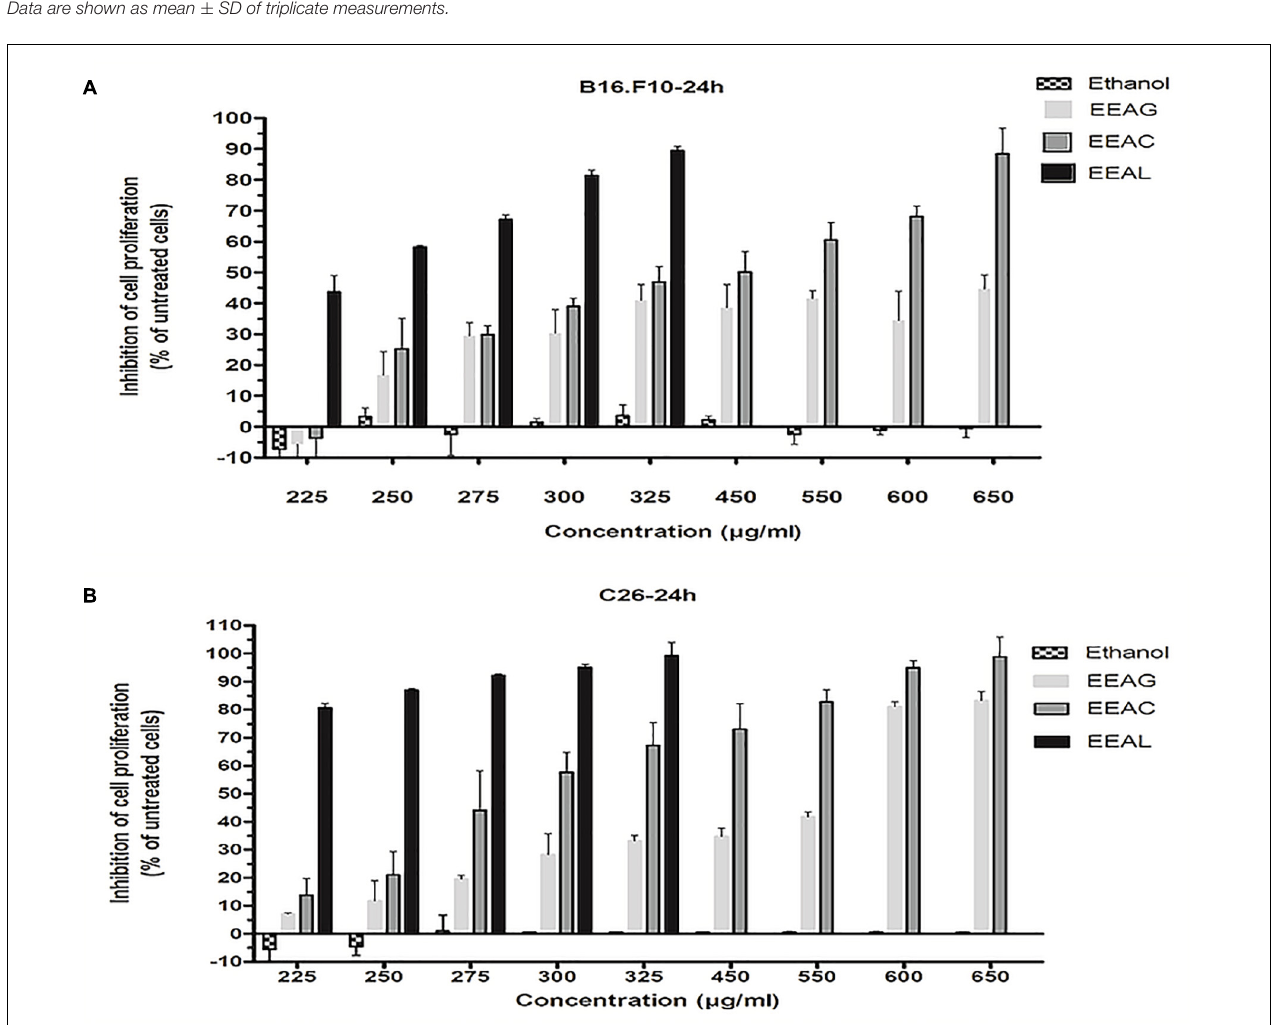
FIGURE 4 | Effects of Ajuga sp. extracts on cell proliferation. (A) 24 h after incubation of B16.F10 cells with different concentrations of EEAG, EEAC, and EEAL extracts. (B) 24h after incubation of C26 cells with different concentrations of EEAG, EEAC, and EEAL extracts. Data are shown as mean ± SD of triplicate measurements. EEAG, A. genevensis ethanolic extract; EEAC, A. chamaepitys ethanolic extract; EEAL, A. laxmannii ethanolic extract. Ethanol-treated cells were used as toxicity